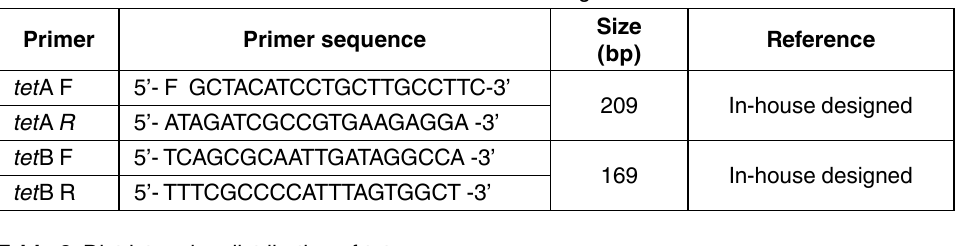
table 3. District – wise distribution of tet genes sl. No.